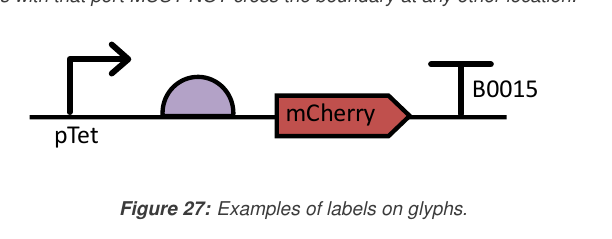
Figure 26: Examples of recommended and problematic module ports: (a) port on a black-box module, (b) ports connected to module internals via mappings, (c) boundary-crossing interaction passing through a port, (d) diagrams SHOULD NOT mix mappings and interactions on a given port, (e) ports MUST NOT be disconnected from their associated glyphs, and (f) if a port exists, interactions with that port MUST NOT cross the boundary at any other location.